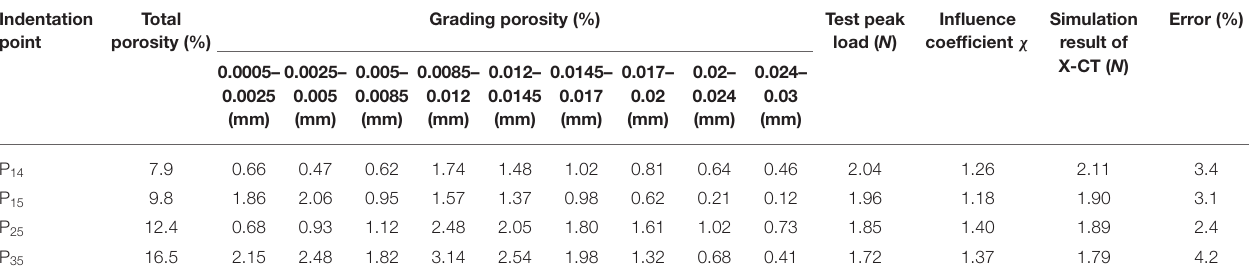
Test peak Influence Simulation load ( N ) coefficient χ result of